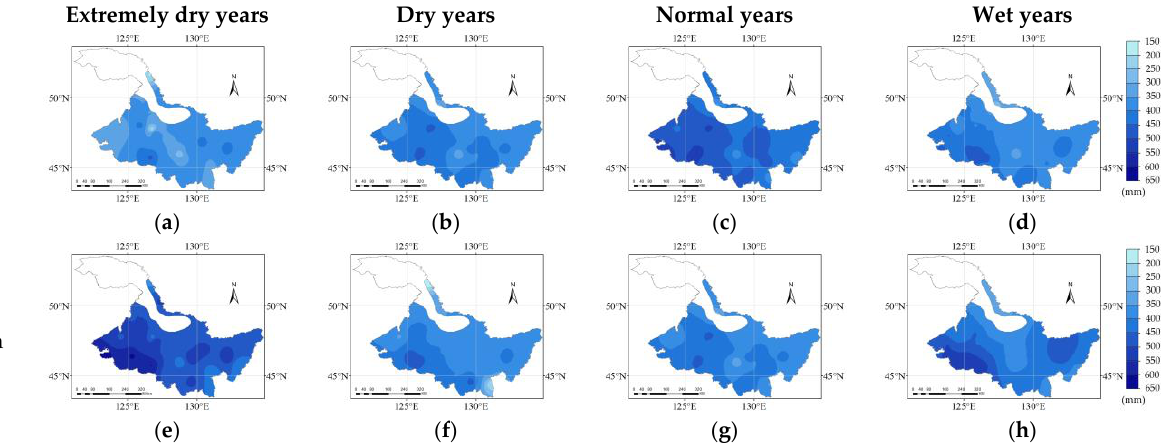
Figure 6. Spatial distribution of ET a and ET c in extremely dry years ( a , e ), dry years ( b , f ), normal years ( c , g ), and wet years ( d , h ) under rainfed and irrigation scenarios.